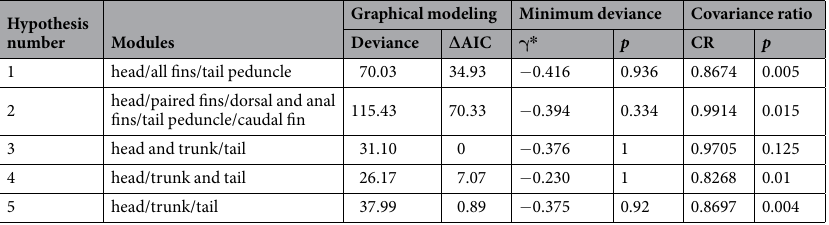
Table 1. Results of the statistical analyses of modularity using graphical modeling, minimum deviance and covariance ratio